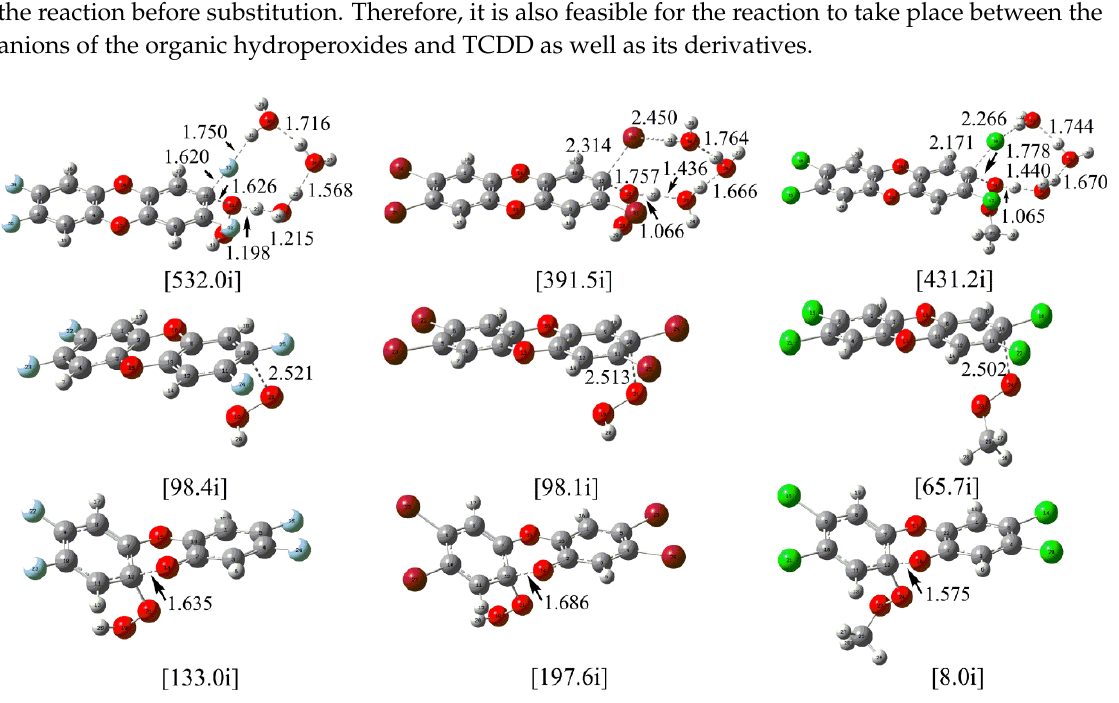
Figure 6. Calculated TSs in the nucleophilic substitution/addition of TCDD and its derivatives by hydroperoxides and their anions (top and middle/bottom), where F-, Br-, and CH 3 - substitutions are shown from left to right, respectively.